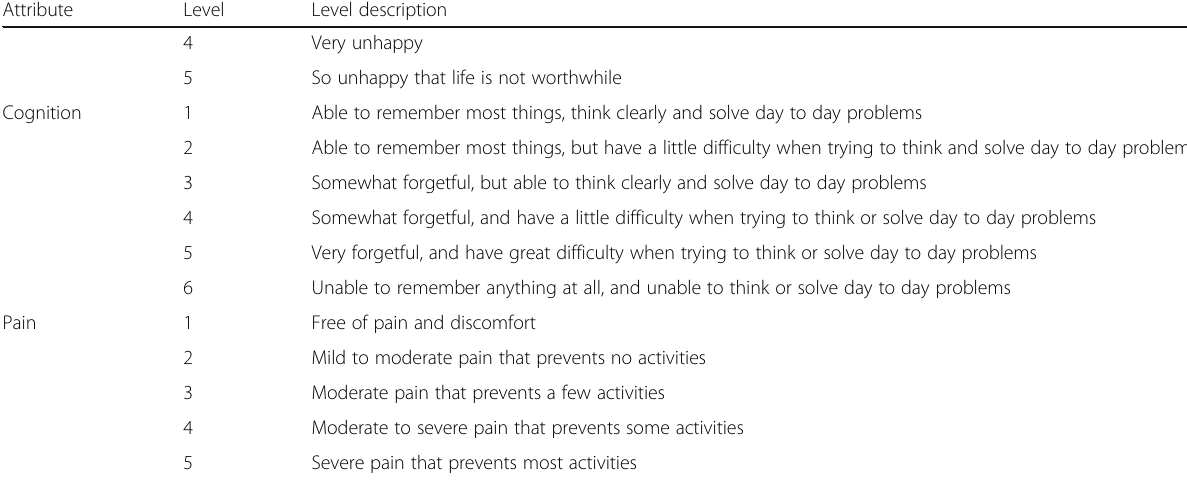
Table 1 HUI Mark III health status classification system (Continued) Attribute